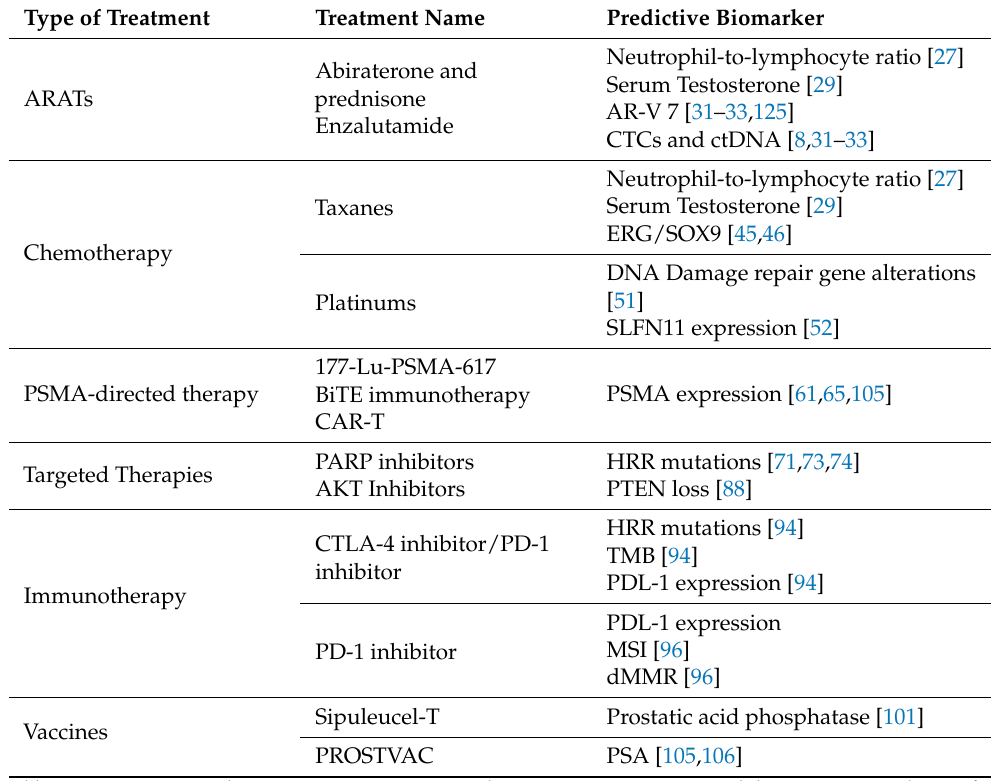
Table A1. Predictive Biomarkers for Treatments of Advanced Prostate Cancer.